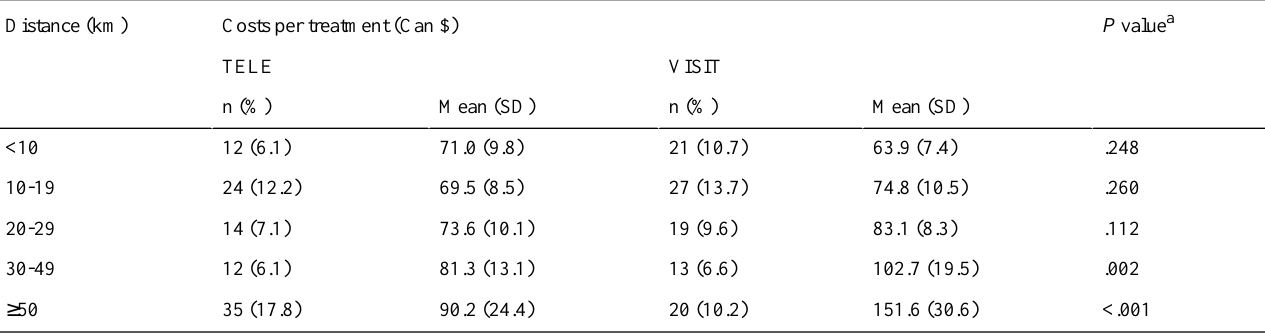
P value a Costs per treatment (Can $)Distance